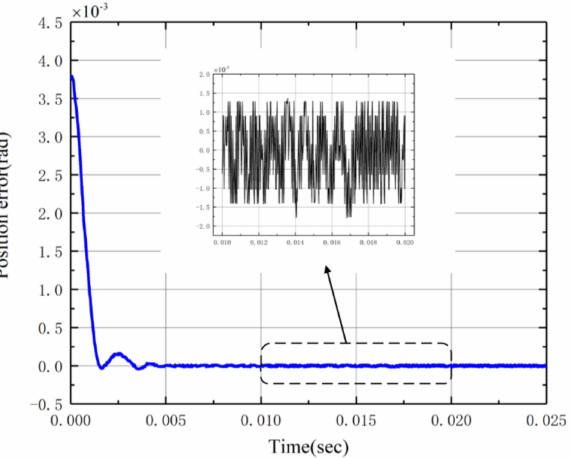
Figure 6. Steady-state error of the step-response in 1% of the whole stroke (0.0038 rad) under the control of the